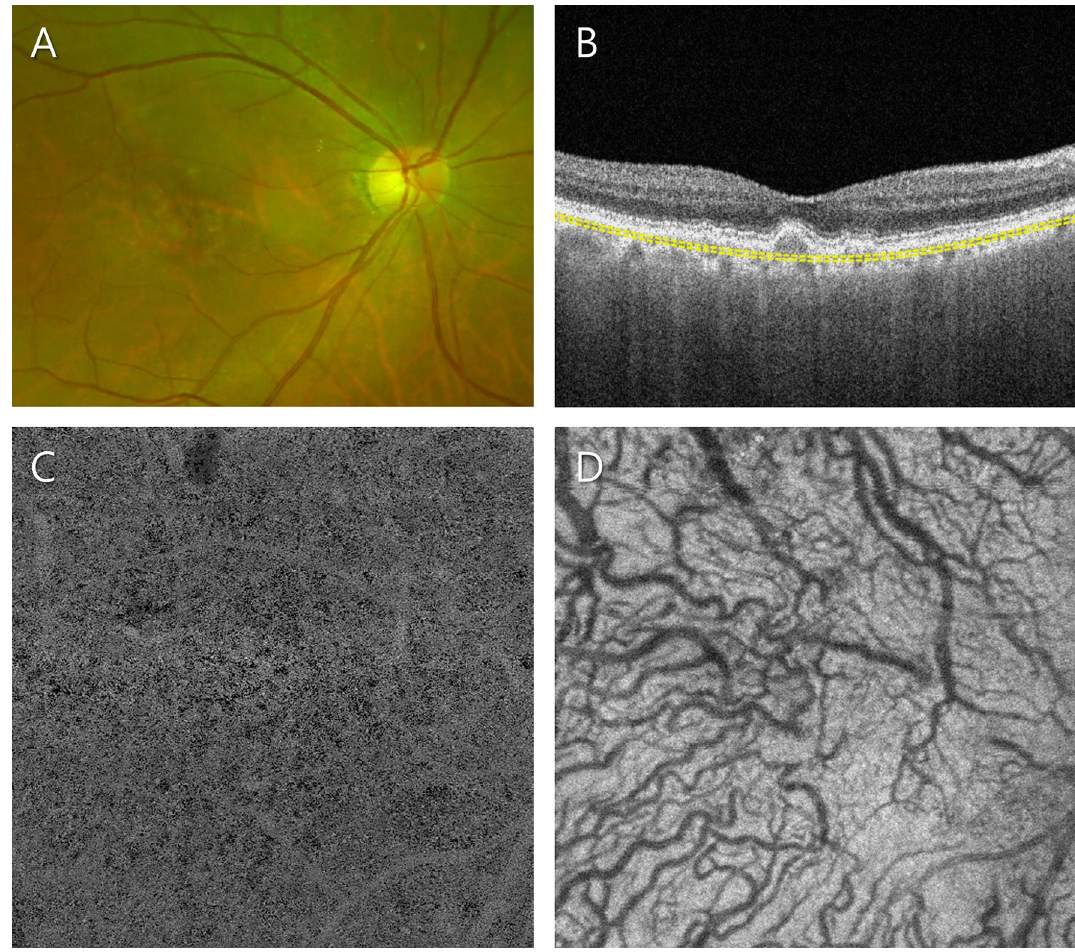
Figure 4. Representative case of a patient in the soft drusen-only group. ( A ) Ultra-widefield fundus photograph showing soft drusen at the macula. ( B ) Optical coherence tomography (OCT) B-scan image. The subfoveal choroidal thickness was 99 µm. Slab to acquire the choriocapillaris (CC) layer is depicted as a yellow dashed line. ( C ) OCT angiography (OCTA) image of the CC. Multiple enlarged flow voids were distributed throughout the scanned area. The average size, number and total area of the flow voids were 369.5 µm 2 , 22,904, and 8.5 mm 2 , respectively. ( D ) Structural en face OCT image of the Haller layer. The mean and standard deviation of the Haller vessel diameter were 77.1 and 33.4 µm,